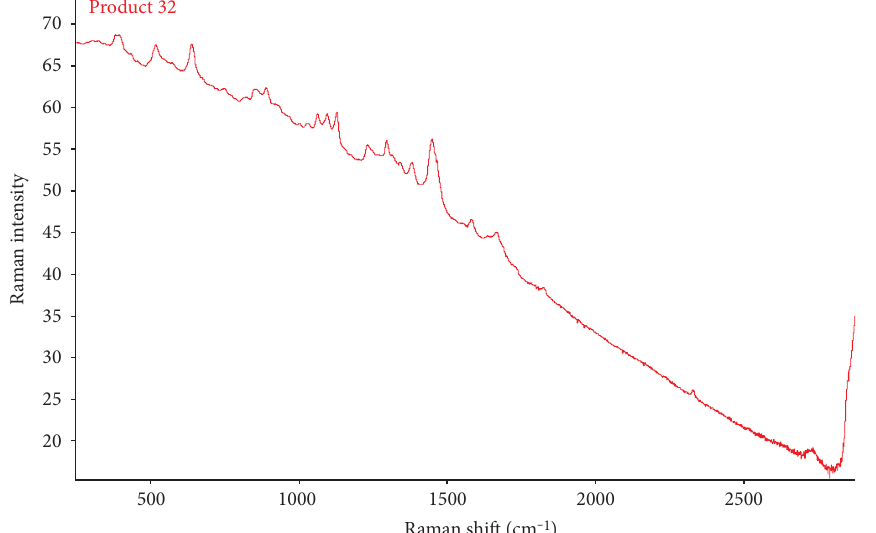
Figure 5: Raman spectrum of product 32. While a strong fl uorescence phenomenon can be observed, the characteristic bands of the product are still visible, enabling a correct identi fi